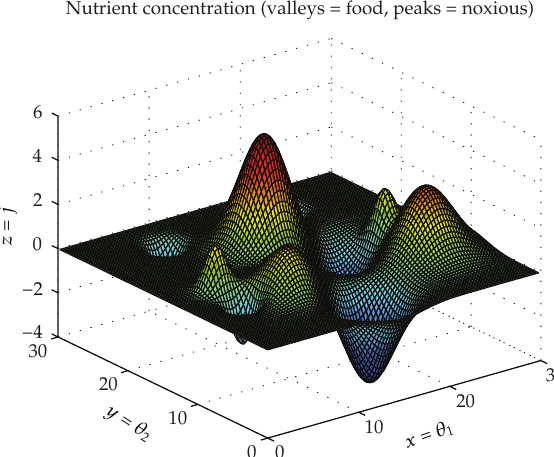
Figure 8: Nutrient-noxious environment.